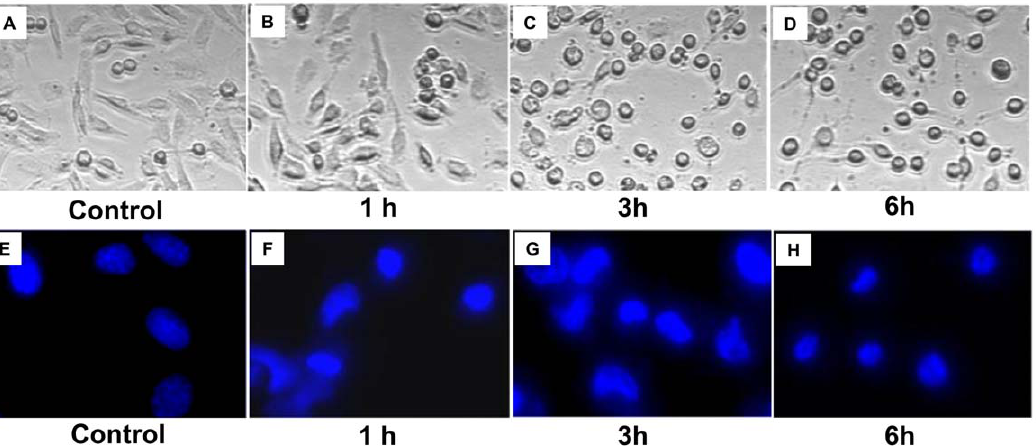
Figure 2. Characterization of morphological changes of H2373 cells induced by H342. A-D, The morphology of the cells was photographed with a microscope. E-H. Untreated and treated cells were rinsed with PBS buffer and stained with Hoechst 33342 (final concentration, 18 m M) for 10 minutes. After staining with Hoechst 33342, the morphological aspects of cell nuclei were observed with a fluorescence microscope.